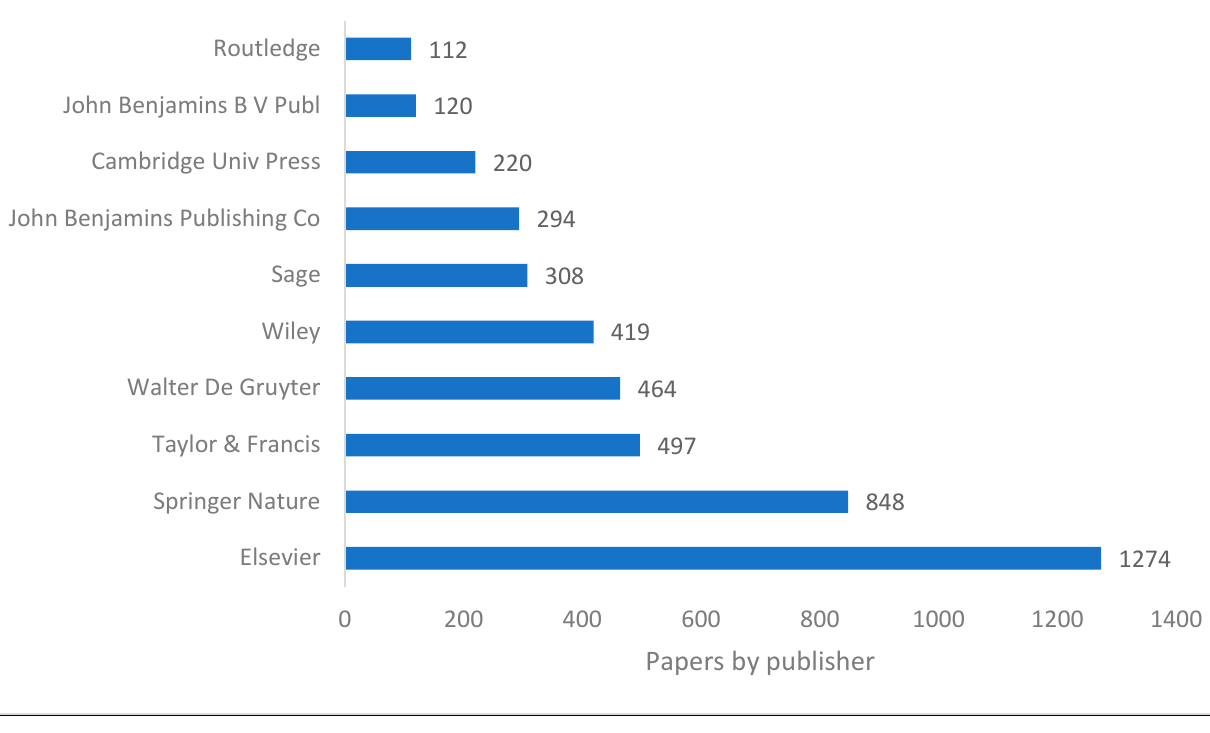
Figure 4. Pragmatics knowledge production size by journal. ( A ) (Scopus). ( B ) (WOS). ( C ) (Lens). Figure 5A,B demonstrate the top publishers in pragmatics according to the data re- trieved from the WOS and Lens. While Elsevier remains the leader in both databases, Springer Nature ranks second in the WOS, but eighth in Lens.